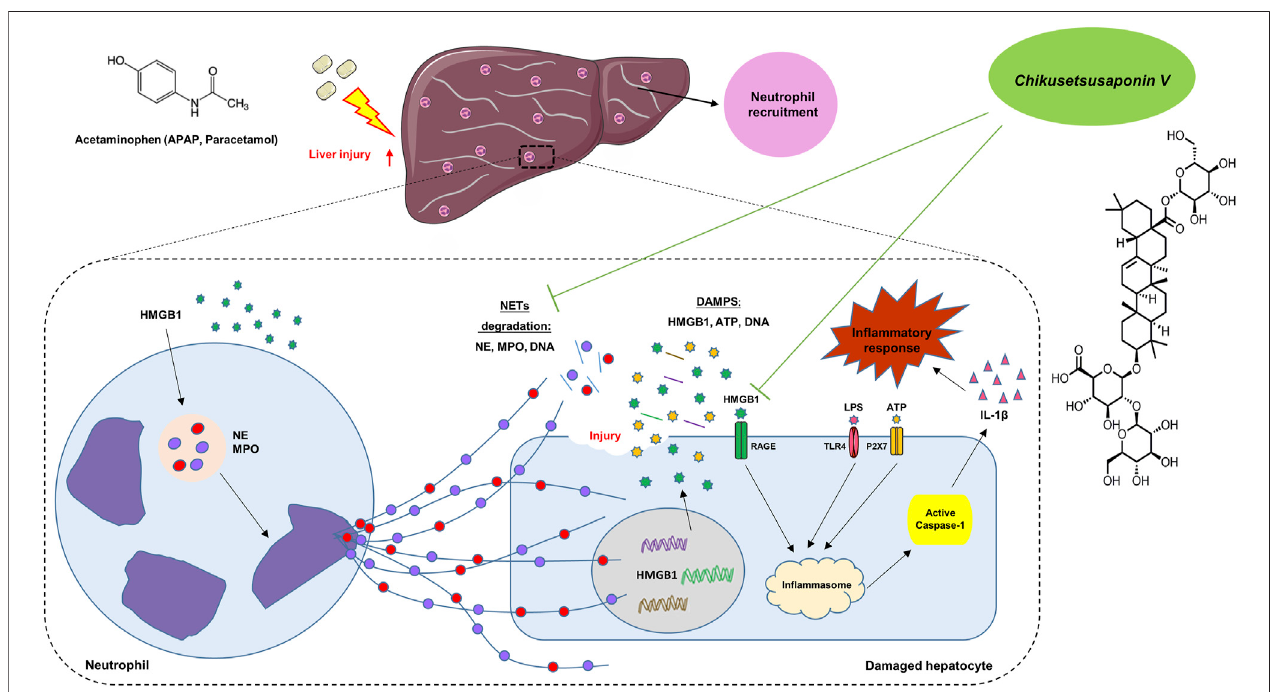
FIGURE 10 | Summary of the underlying mechanism of CKV on alleviating APAP-induced hepatic injury.